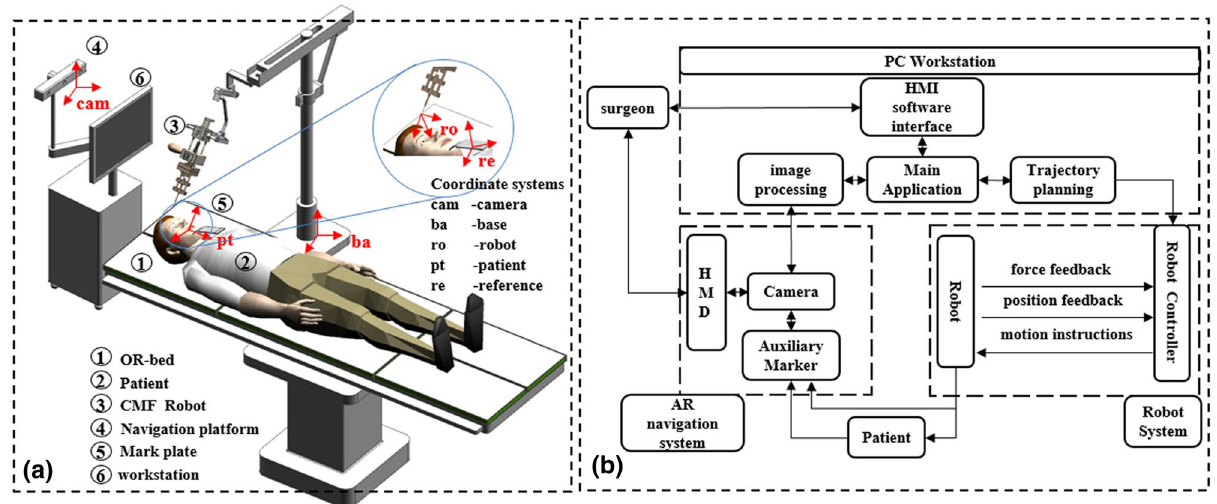
Figure 4. The robot system: ( a ) the structure diagram; ( b ) the system structure